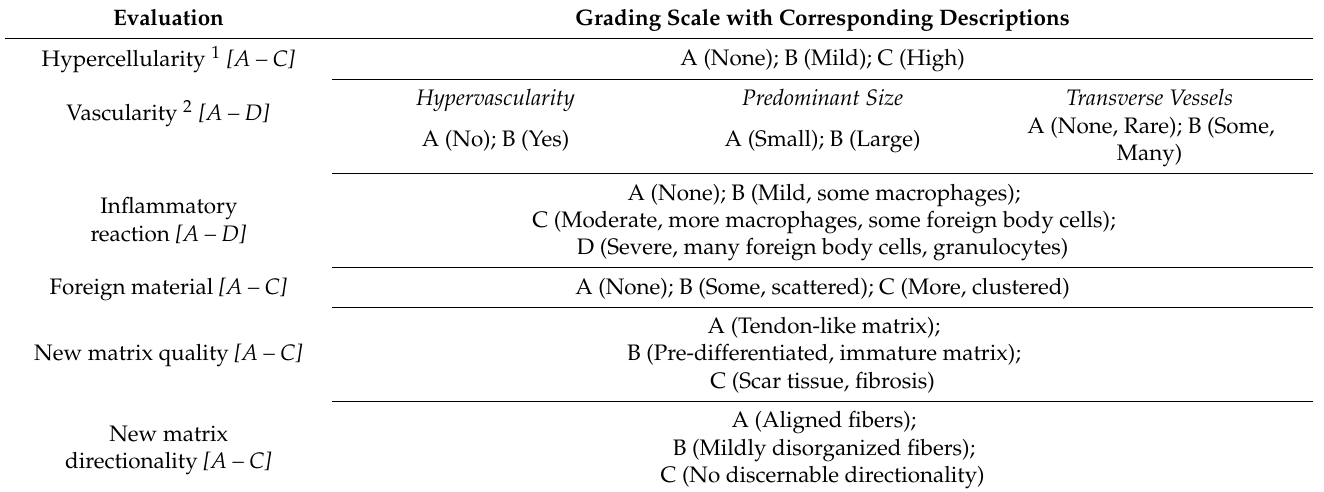
Table 3. Scoring table for microscopic evaluation (i.e., 10 × enlargement) of sections from the operated tendons (i.e., two zones) 6 weeks after intervention and